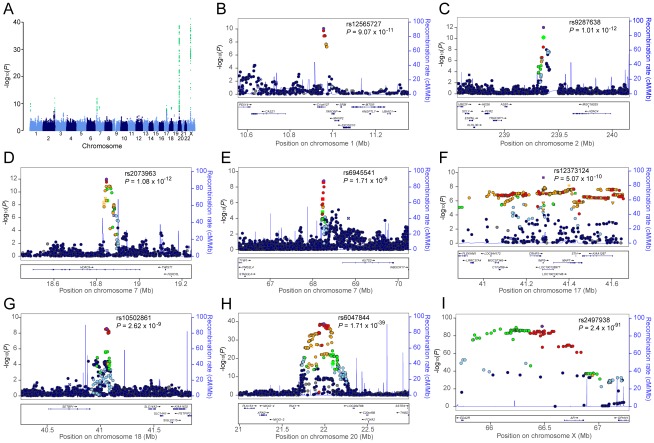
Genome-wide meta-analysis results for AGA in MAAN.(A) Manhattan plot showing the −log10 p value of SNPs against their chromosomal positions. The genome-wide significant SNPs are green (p value<5×10−8). The points with p value <1×10−40 were truncated; the smallest p value was 2.4×10−91 at AR gene. (B–I) Regional association plots for eight loci associated with AGA. In each panel, the lead SNP is denoted in purple with its rs ID and association p value. The color of other SNPs indicates the LD with the lead SNP as red (0.8≤r
2≤1), orange (0.6≤r
2<0.8), green (0.4≤r
2<0.6), light blue (0.2≤r
2<0.4), and dark blue (r
2<0.2). Estimated recombination rates are in light blue.